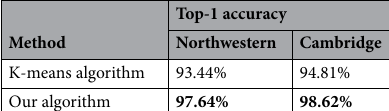
Table 10. Accuracy comparison of keyframe algorithm. Significant values are in